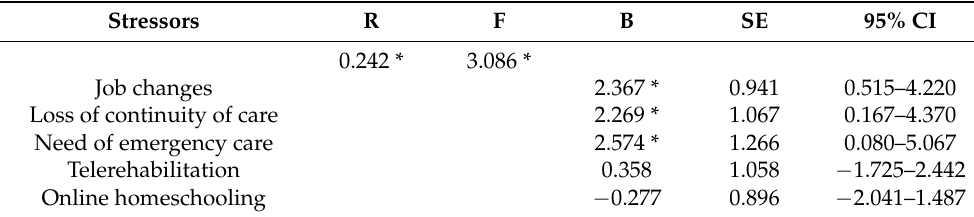
Table 4. The multiple regression linear model examining the association between the PSS total score and potential